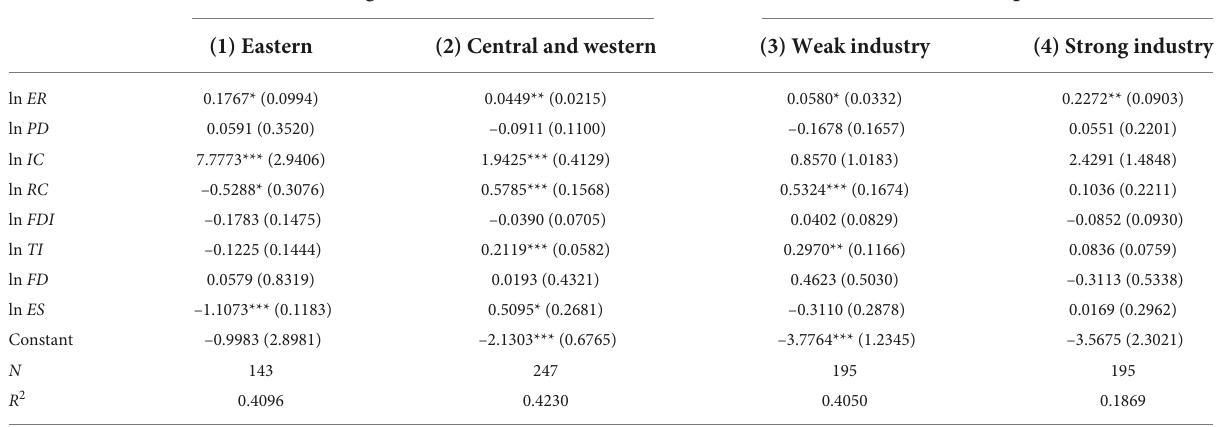
TABLE 3 Regional robustness test results.